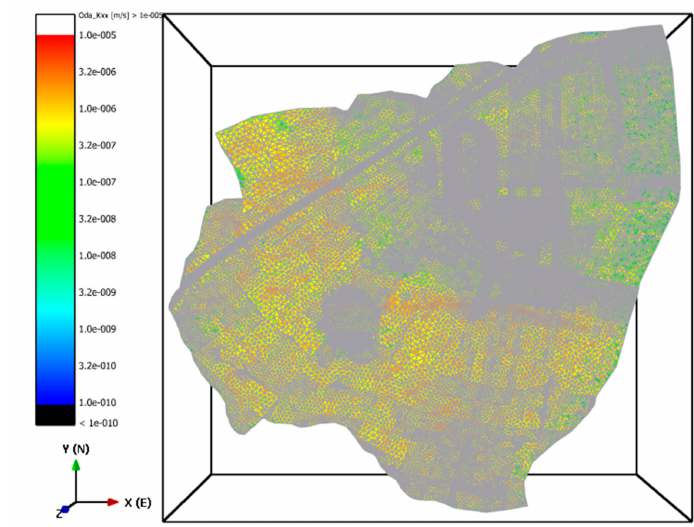
Figure 10. FEFLOW grid for upscaling.